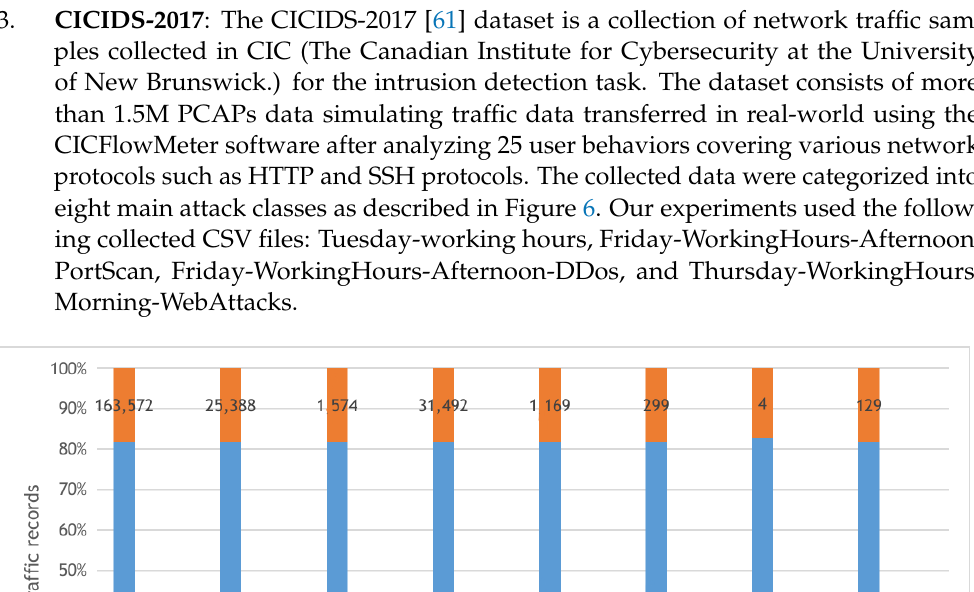
Figure 5. The Bot-IoT dataset training and testing sets distribution.